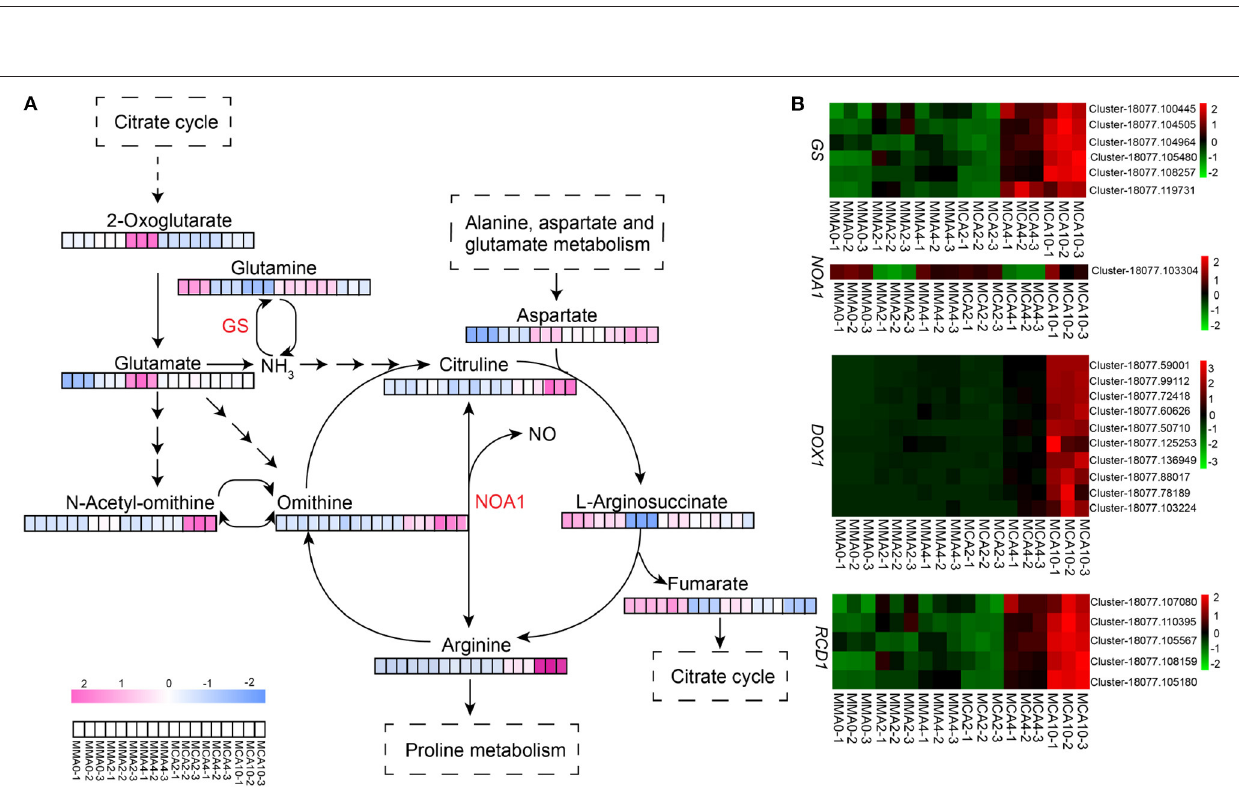
FIGURE 6 | The expression of metabolites and genes related to arginine biosynthesis pathway. (A) Heatmap of key metabolites of arginine biosynthesis pathway. (B) Heatmap of key genes which might relate to arginine biosynthesis. GS, glutamine synthetase; NOA1, nitric oxide associated protein 1; DOX1, α -dioxygenase gene1; RCD1, radical-induced cell death1